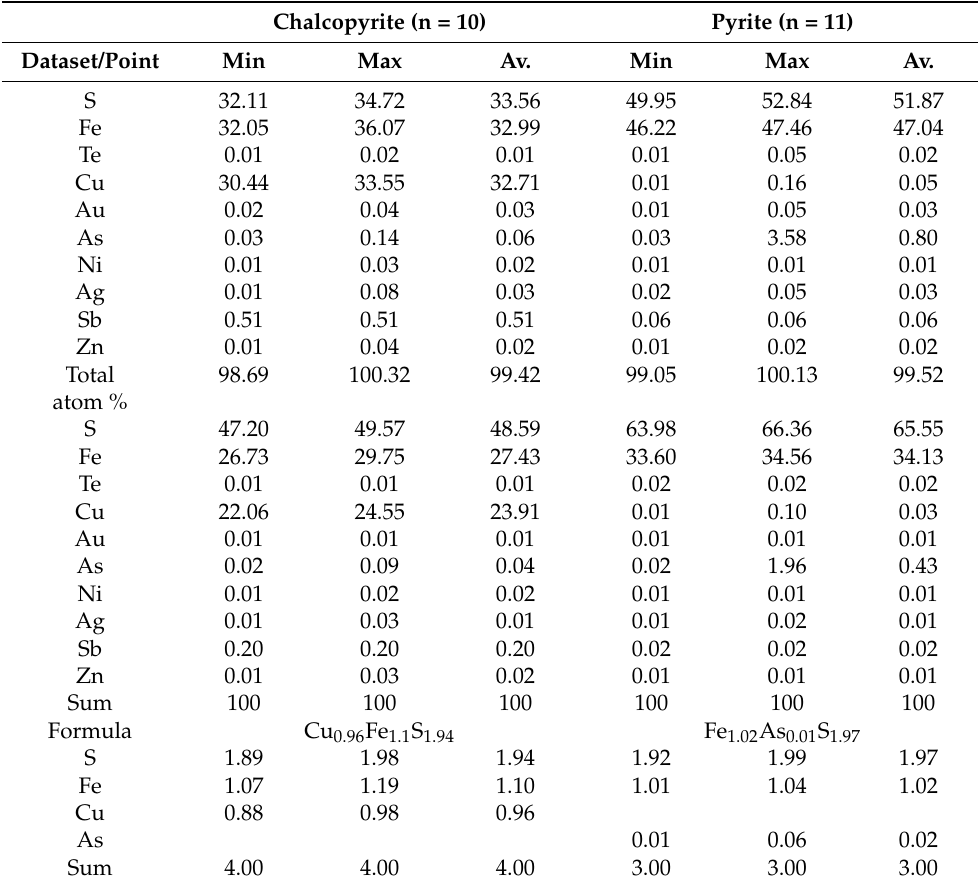
Table 1. Representative electron microprobe data of chalcopyrite and pyrite from Abu Zawal (Fatira)